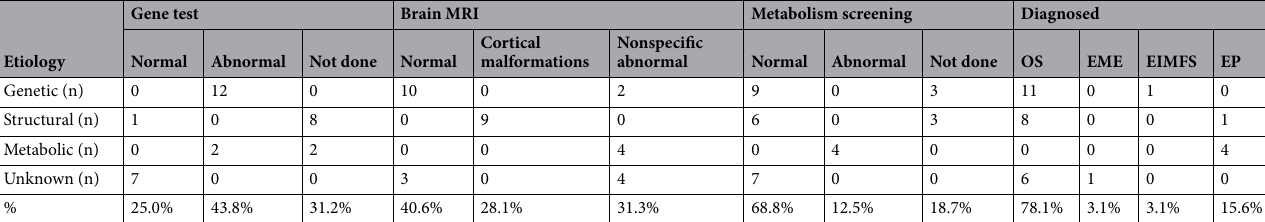
Table 1. The etiologies of patients. OS Ohtahara syndrome, EME Early myoclonic encephalopathy, EIMFS Epilepsy of infancy with migrating focal seizure, EP Epilepsy, MRI Magnetic resonance imaging.